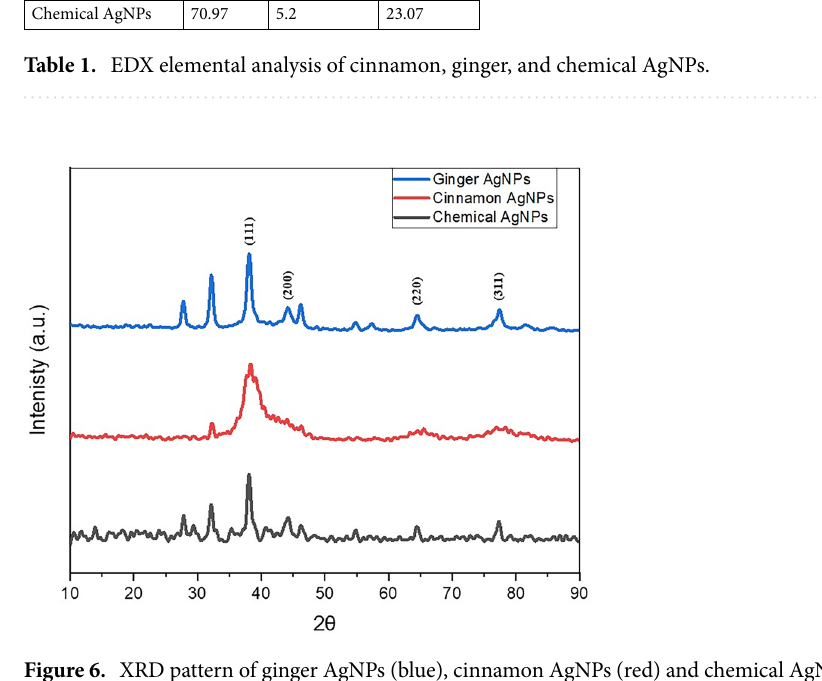
Figure 6. XRD pattern of ginger AgNPs (blue), cinnamon AgNPs (red) and chemical AgNPs